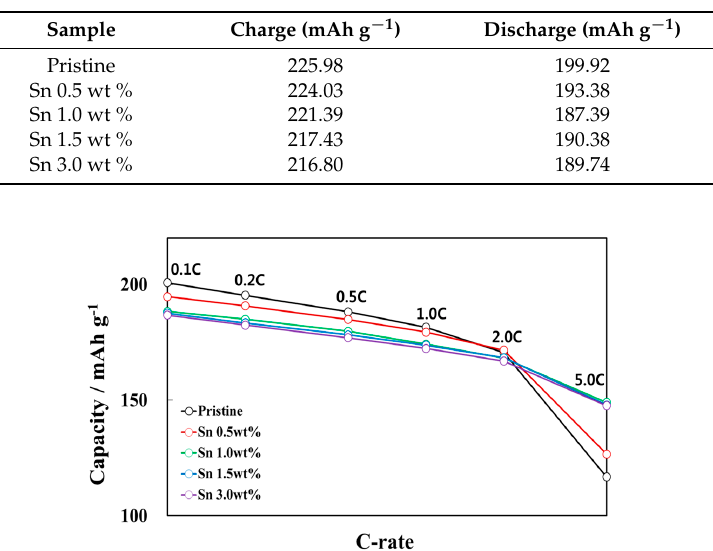
Figure 5. Initial charge–discharge profiles of the cathode active materials. Table 3. Initial charge–discharge capacity of the cathode active materials.